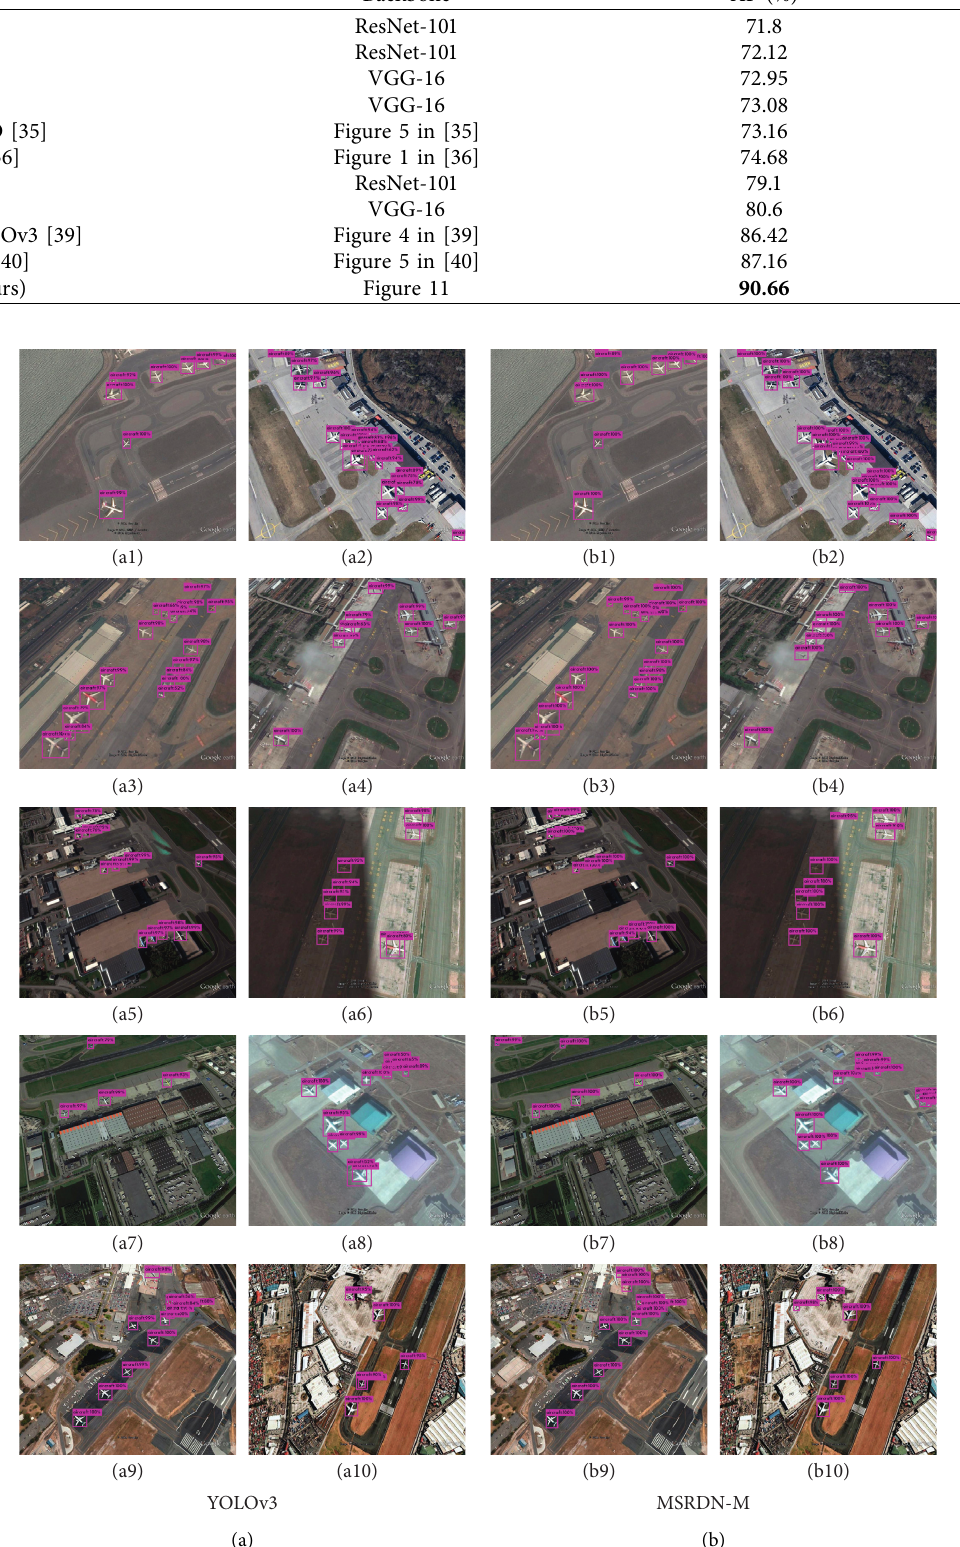
Figure 17: The comparison detection results of YOLOv3 and MSRDN-M for the aircraft. (a1–a10) The detection results of YOLOv3. (b1–b10) The detection results of MSRDN-M for the